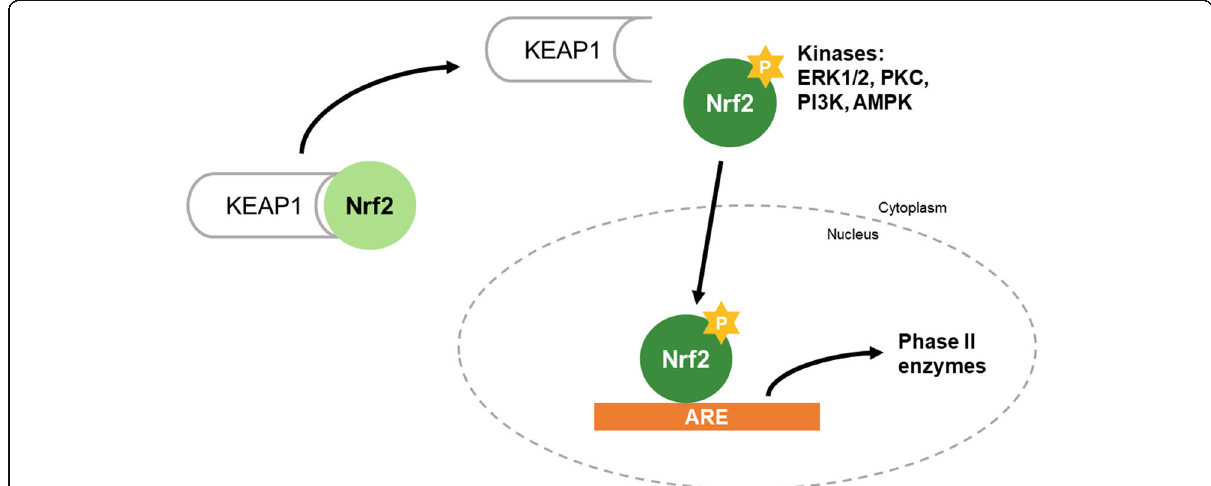
Fig. 1 Mechanism of the Nrf2 pathway. Under oxidative stress condition, Nrf2 separates from Keap1 via phosphorylation of it by various kinases. Nrf2 translocated into nucleus and binds to ARE region on promoter of the target gene including HO-1 and